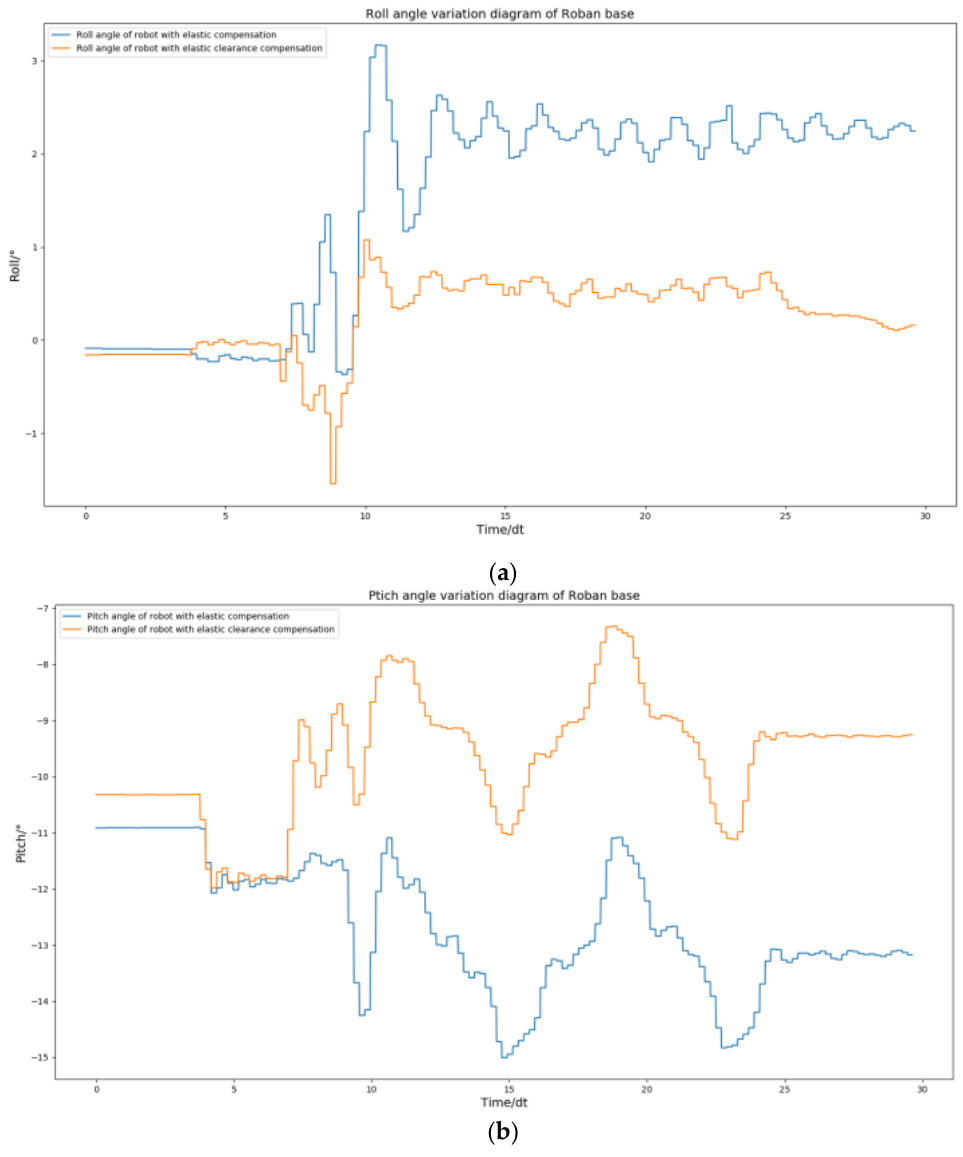
Figure 28. The Roban robot performs a forward swing motion. We obtained the curve comparison diagram of roll angle and pitch angle of the robot with and without spring clearance compensation in this process. ( a ) Comparison diagram of roll angle change of robot with and without spring compensation. ( b ) Comparison diagram of pitch angle change of robot with and without spring compensation.